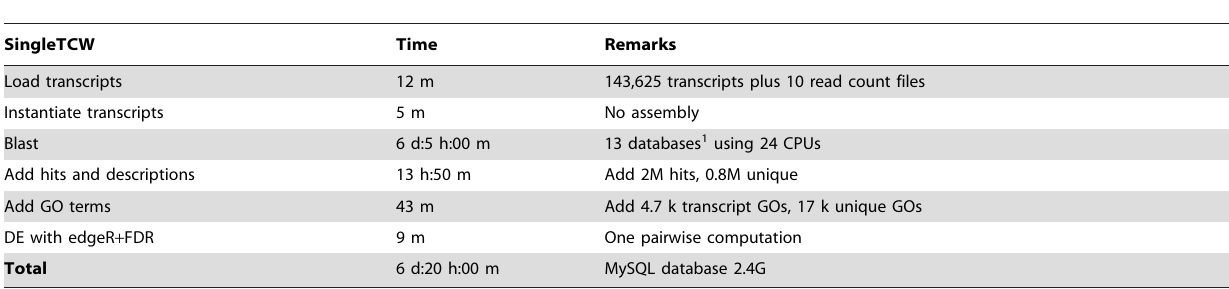
Table 1. Timing results for building a singleTCW database.